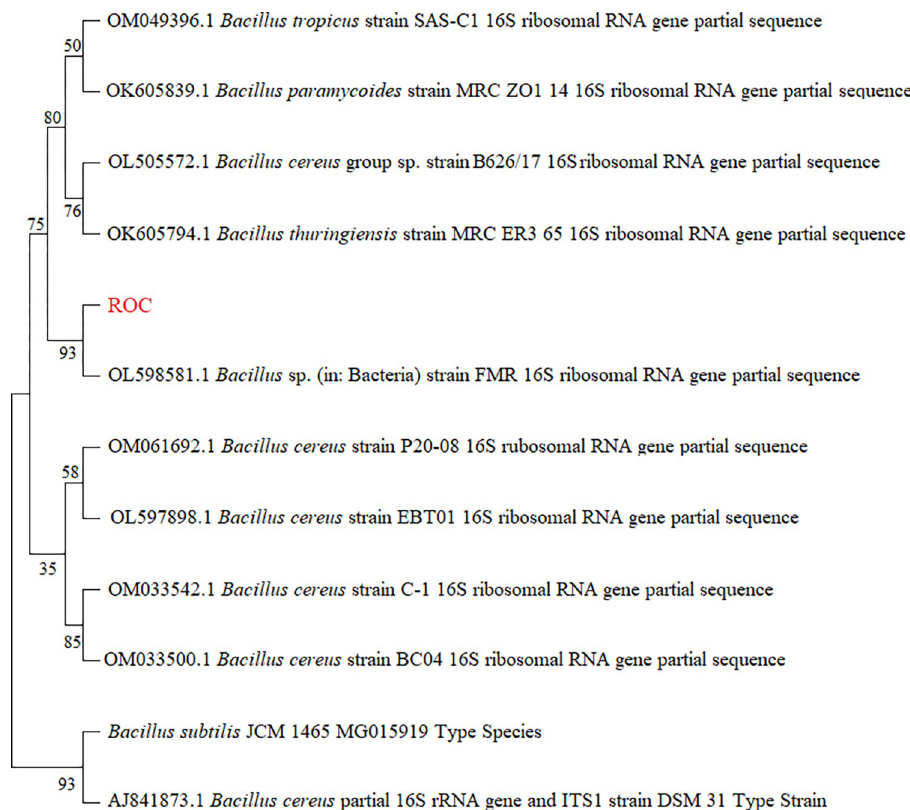
Fig 1. Neighbor-joining phylogenetic tree of the representative bacterial strain ROC and its related species based on the 16S rRNA gene sequences.